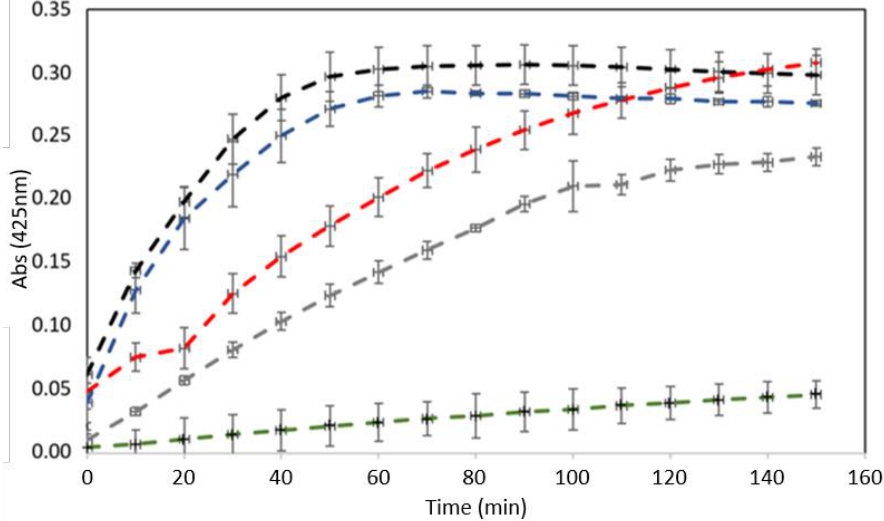
Figure 2. Enzymatic activity of BmPLA2 incubated with specific substrate (4N3OBA). Legend color: BSA, negative control (green); commercial PLA 2 (gray); B. moojeni crude venom (black); peak F3 from Sephacryl S-100 (blue); and BmPLA2 (red).